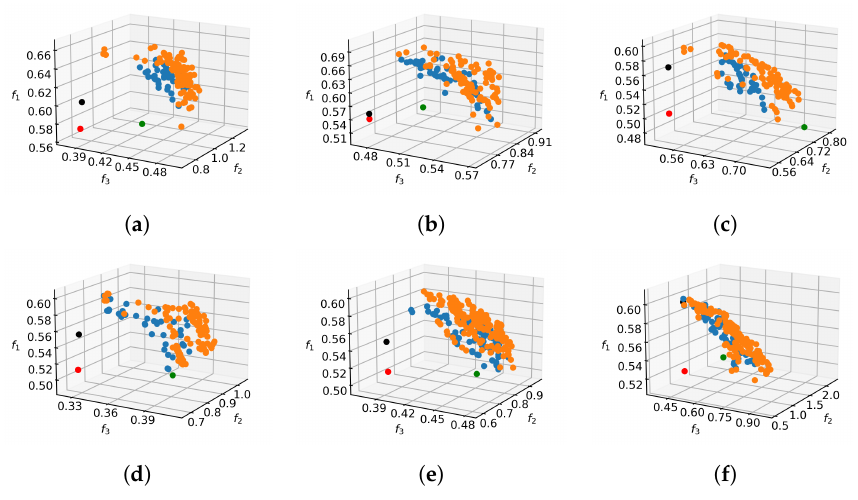
Figure 7. Non-dominated sets obtained by NSGA-II (blue) and SPEA2 (orange) for the corresponding trees from Figure 6. The plots include reference objective vectors for no pruning (red), cylindrical pruning (green), and rule-based pruning (black).